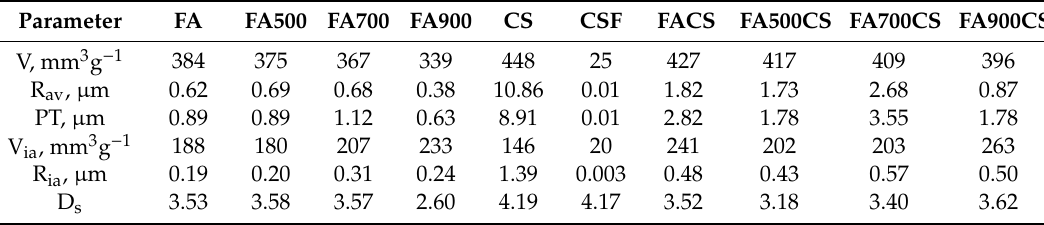
Table 2. Mesopore parameters of the studied adsorbents. V mesopore volume, R average mesopore radius,